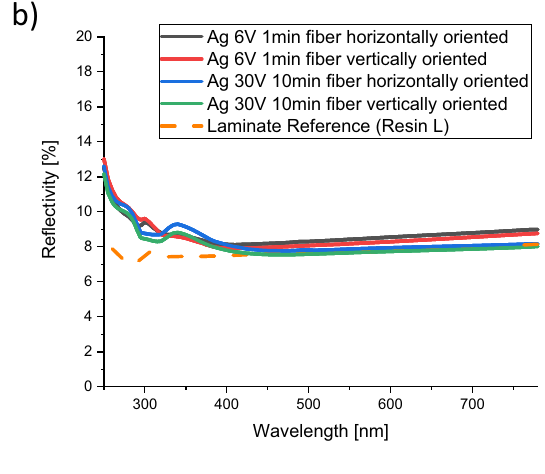
Figure 13: Ag fi ber modi fi cation via EPD ( a ) before and ( b ) after